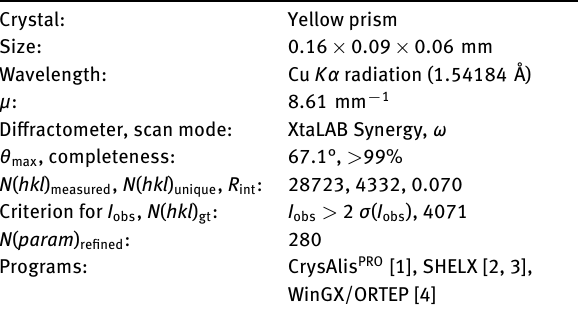
Table 1: Data collection and